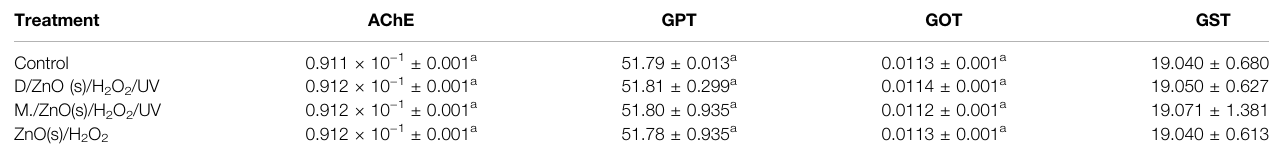
TABLE 2 | Effect of ZnO(nano)/H 2 O 2 /UV with and without dimethoate and methomyl on the activity of some biochemical parameters in rats.